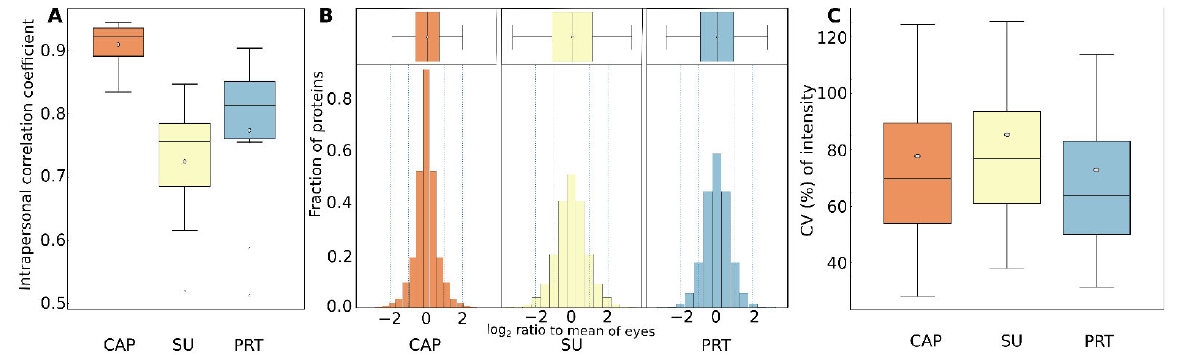
eyes relative to the average of the two eyes. ( C ). Distribution of coefficients of variation (CV%) for intensities of proteins in Cluster A in all samples of different sampling